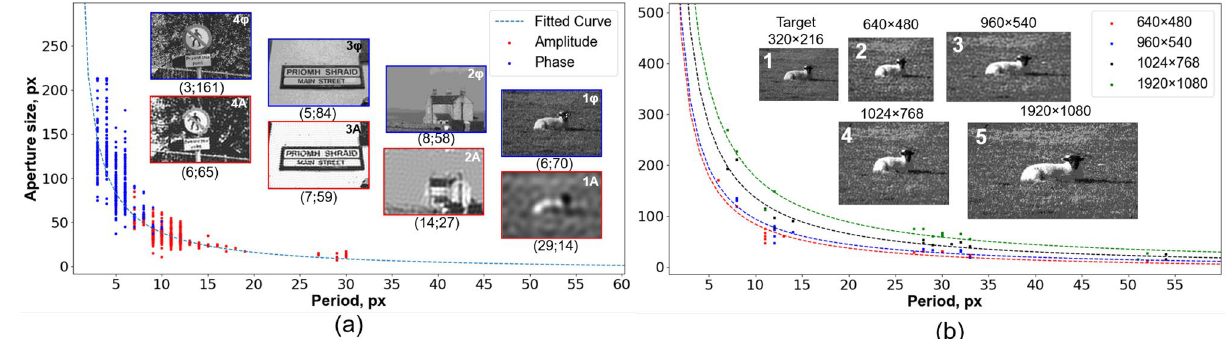
Figure 5. Minimal RMSE graph for amplitude-type and phase-type modulation. Approximation curves are plotted using specified points and are of hyperbola type. ( a ) The minimum RMSEs for dataset 54 are indicated with red (amplitude-type) and blue (phase-type) dots. The insets show amplitude (red rectangles) and phase (blue rectangles) distributions, obtained using parameters which presented below each image in the form of (period; aperture size). ( b ) Minimal RMSE points for 10 different objects and different sizes equal to DMD matrix sizes for amplitude- and phase-type modulation. The insets show amplitude distributions, modulated using different DMD display resolutions which are presented above each